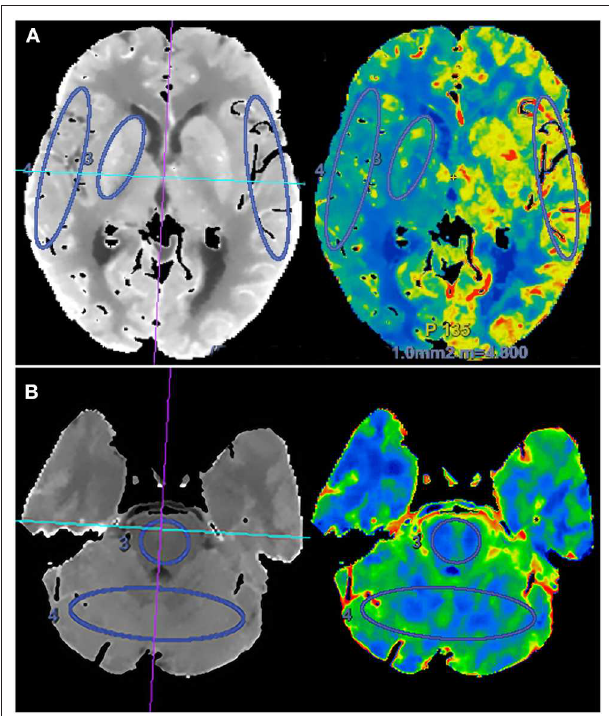
FIGURE 1 | Schematic diagram of regions of interest (ROIs) in the region of perforating artery territory (PAT) and cortical artery territory (CAT) in anterior circulation (A) and posterior circulation (B)